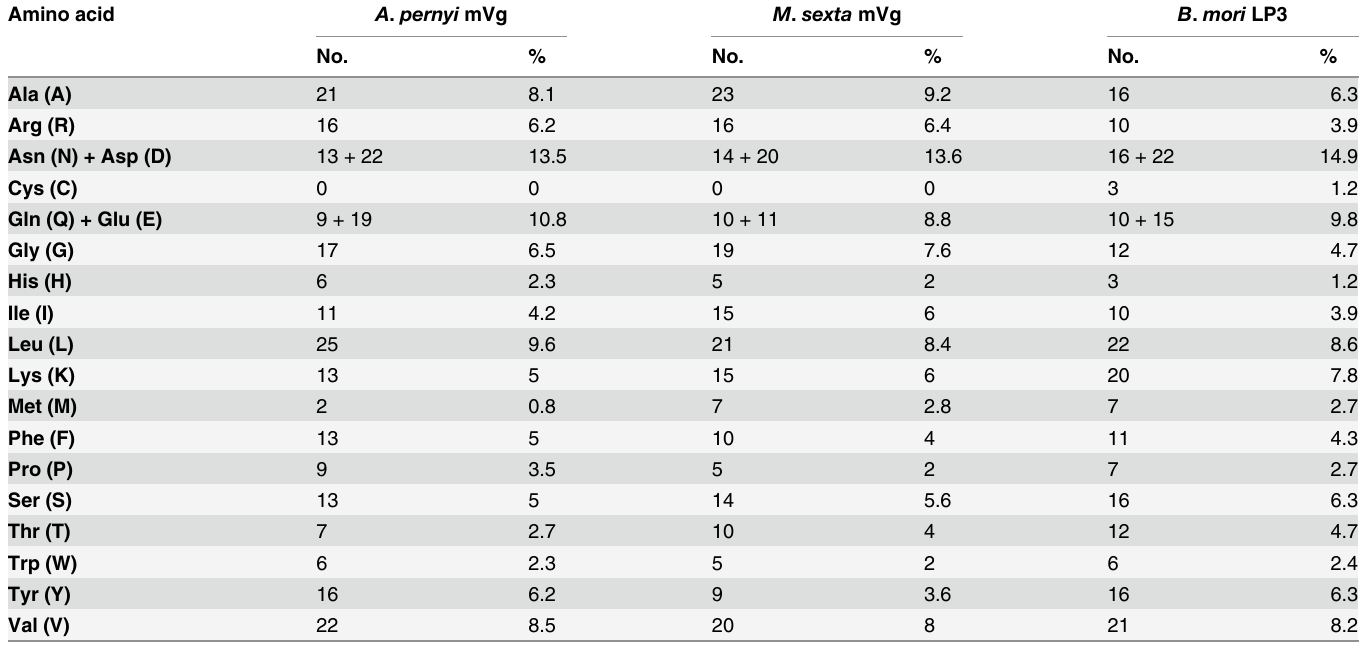
Table 2. Amino acid composition comparison among A . pernyi mVg, M . sexta mVg, and B . mori LP3. Amino